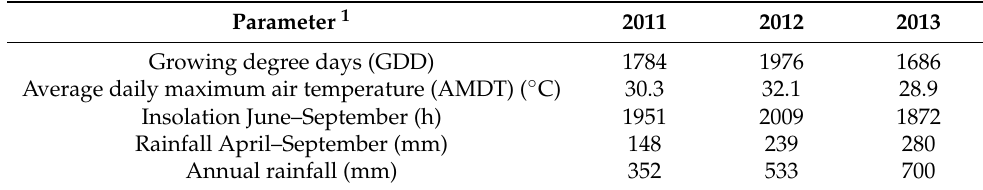
Table 1. The selected weather parameters of the experimental years (2011–2013). Growing degree days (GDD; base 10 ◦ C), rainfall registered during the bud burst to harvest period, annual rainfall, insolation and average daily maximum air temperature (AMDT) during the veraison to harvest period for Cabernet Sauvignon